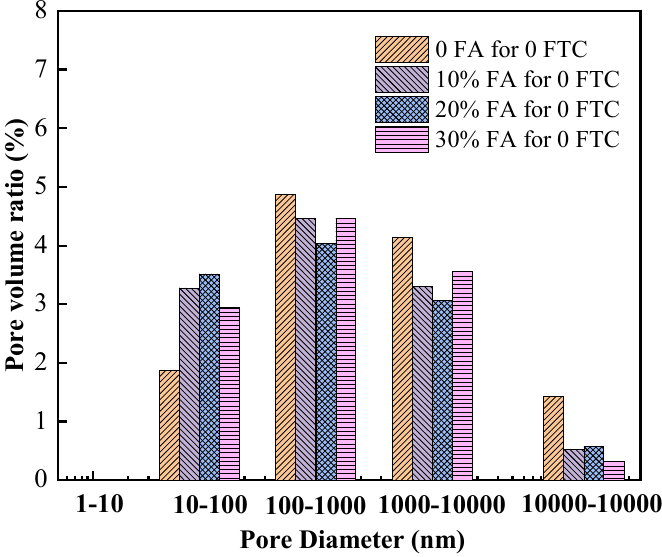
Figure 9. Pore size distribution under 0 FTC.